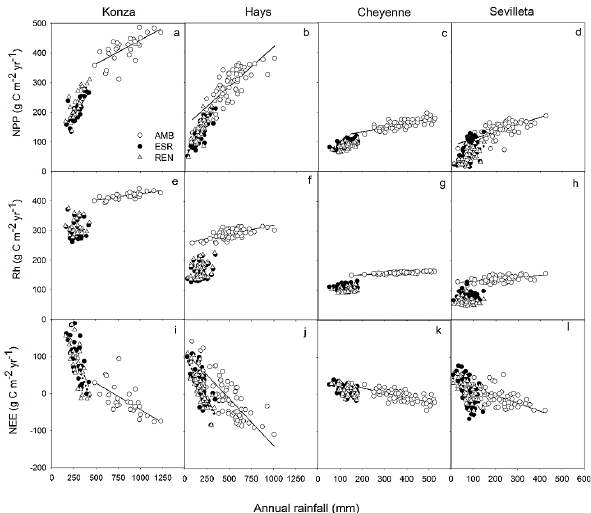
Fig. 4. Relationships between annual rainfall and annual C fluxes under the three rainfall scenarios (AMB: ambient rainfall; ESR: rainfall event size reduction; REN: reduced event number) in four North American grasslands (Konza: a , e and i ; Hays: b , f and j ; Cheyenne: c , g and k ; Sevilleta: d , h and l ). Annual rainfall deter- mined grassland ecosystem carbon fluxes.